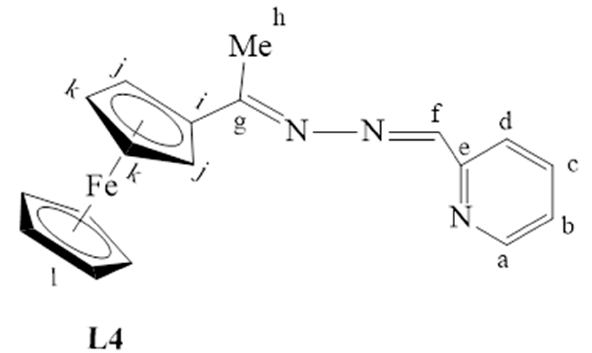
Figure 26. The chemical structure of L4